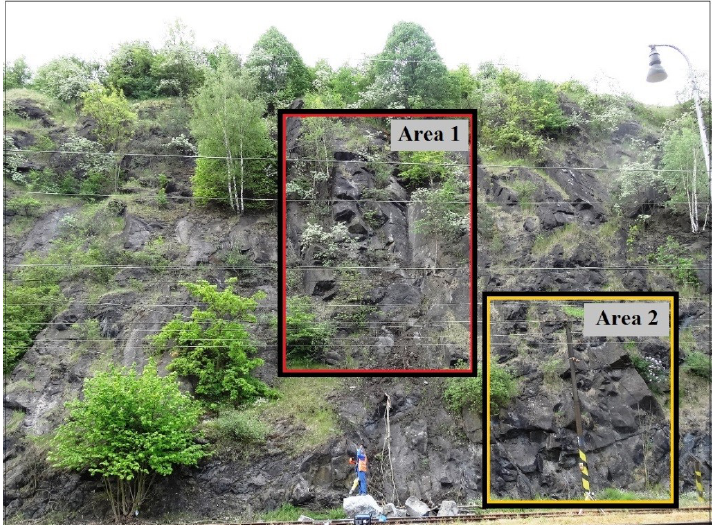
Figure 5. Dangerous areas of the rock